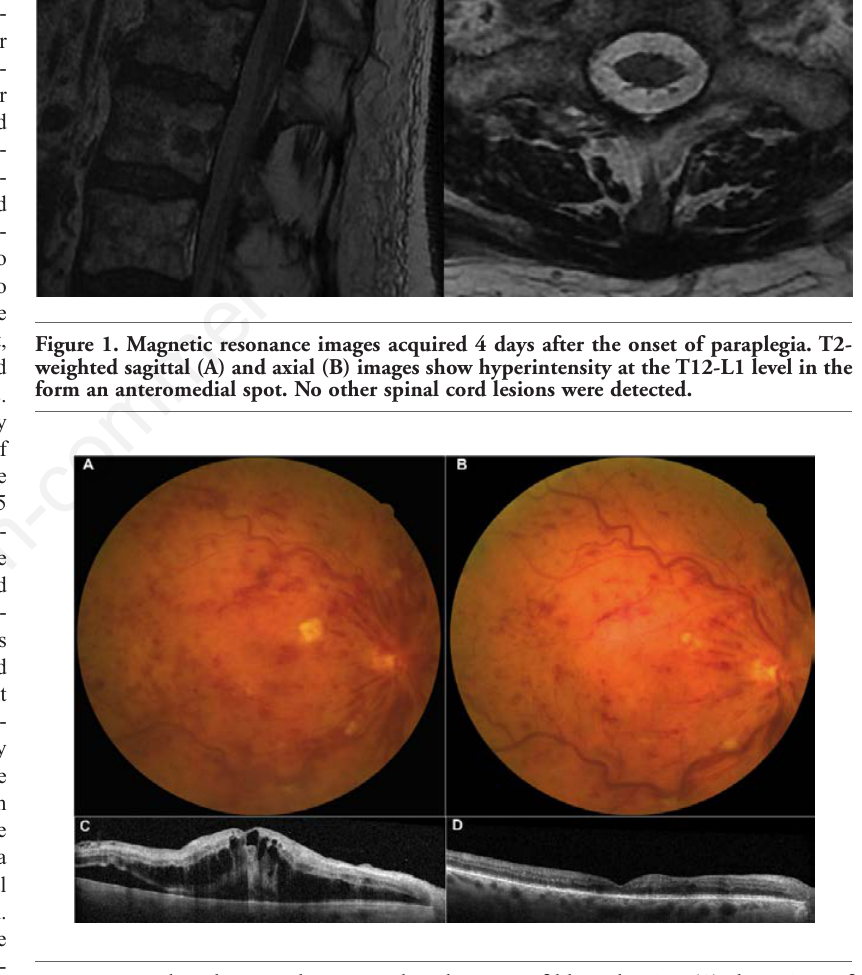
Figure 2. Fundus photography acquired at the onset of blurred vision (A) show signs of central retinal venous occlusion, such as retinal hemorrhage, venous tortuosity, cotton- wool spots, and optic nerve edema. Optical coherence tomography image shows a cystoid macular edema associated with serous retinal detachment (B). Six months later, the signs of central retinal venous occlusion show partial regression (C), with subtotal resorption of the macular edema after four intravitreal injections of anti-vascular endothelial growth factor drug (Aflibercept;